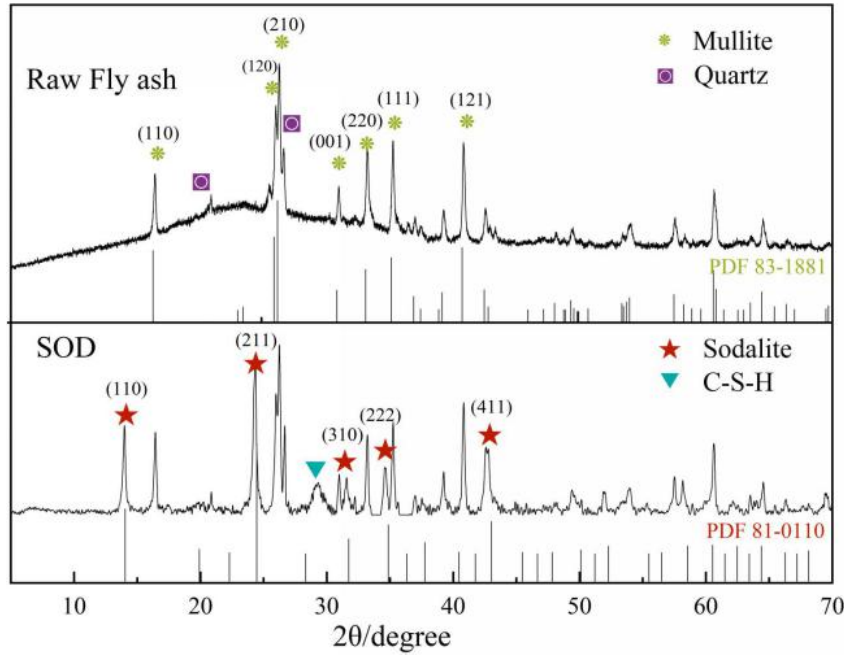
Figure 1. XRD patterns of raw material (FA) and synthetic product (SOD).